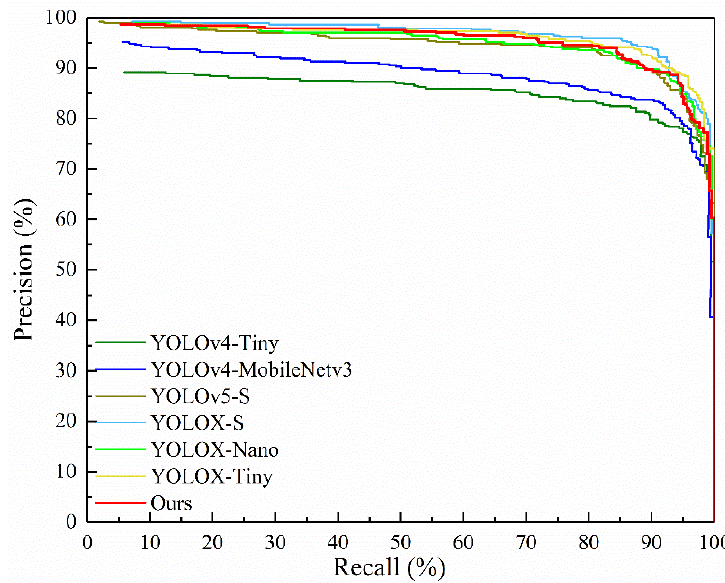
Figure 10. PR curves for the six lightweight detection models. Table 3. Detection results with different lightweight